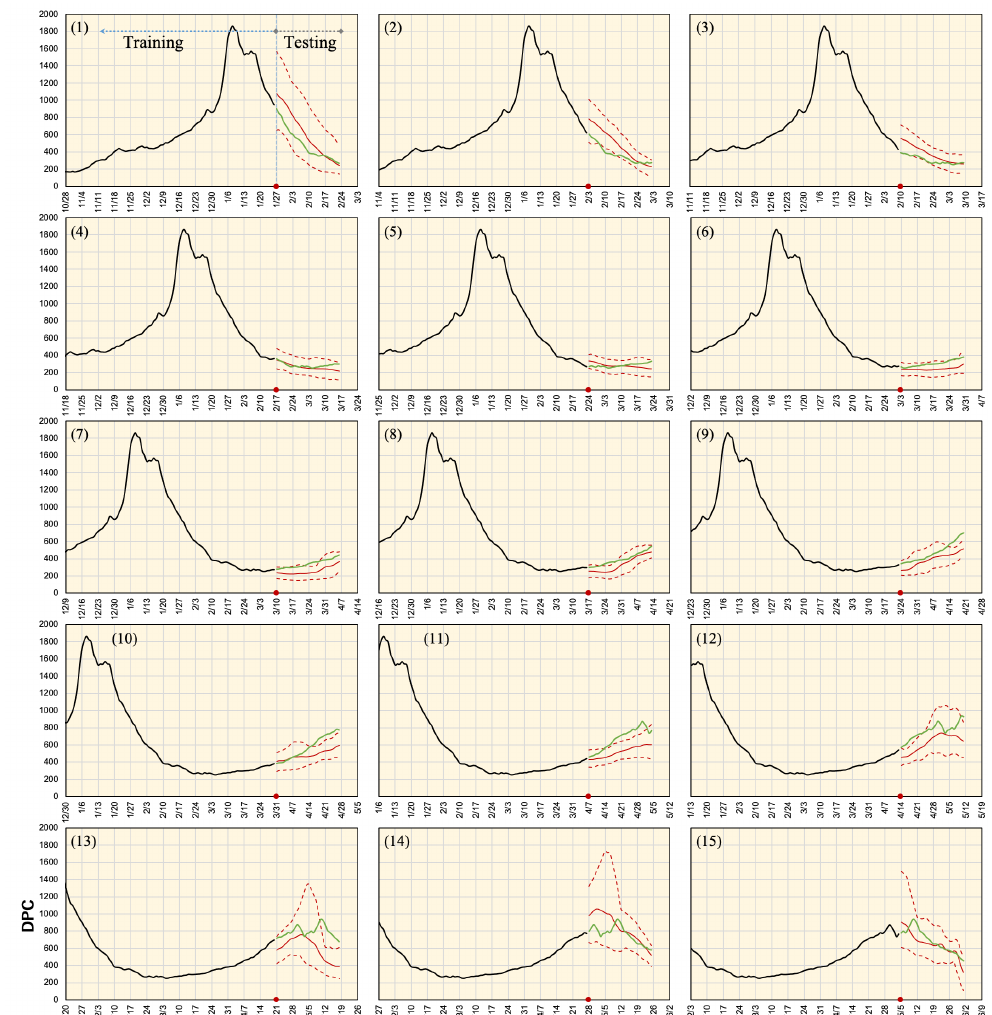
Figure 5. Actual and estimated DPC in Tokyo for different time phases as defined in Table 1. Black and green colors demonstrate actual reported data used for training and validation, respectively. Solid and dashed red lines are the average and maximum/minimum bounds, respectively. Earlier data records from 15 February 2020 are also included in the network training.